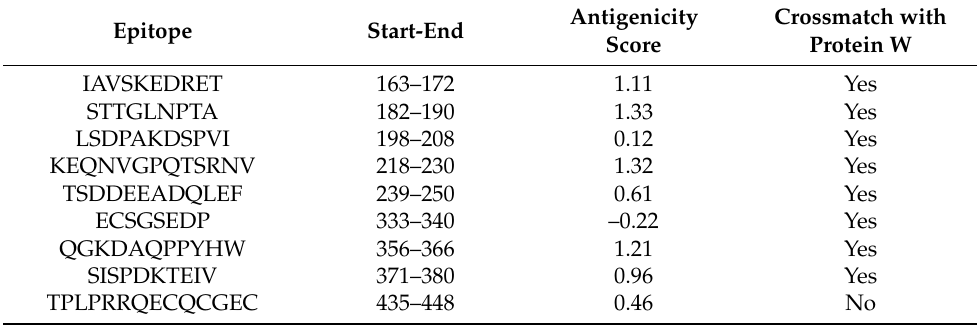
Table 2. Predicted B cell epitopes from V protein.